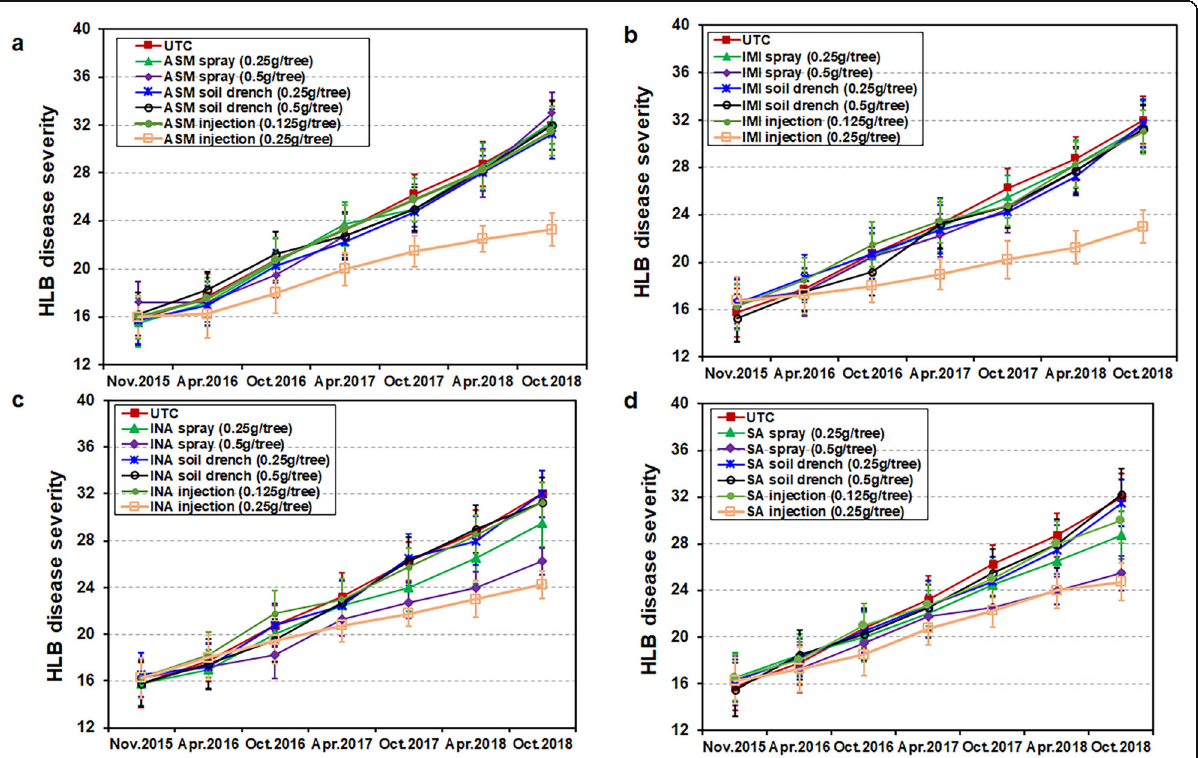
Fig. 1 HLB disease severity progression of Hamlin sweet orange trees following treatments with SAR inducers. a Disease progression under ASM treatments. b Disease progression under IMI treatments. c Disease progression under INA treatments. d Disease progression under SA treatments. The mean of disease severity was calculated from evaluations of the treated trees. Disease severity scores were shown as means and error bars (standard deviation) ( n = 6). The untreated control (UTC, spray with water only) was included in each panel for comparison